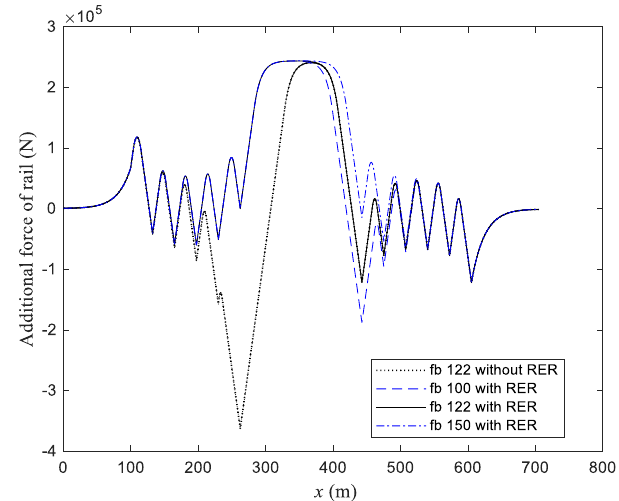
Figure 14. Additional force of rail along its length, with the fixed bearing located at three different positions for the length of 180 m of continuous beam.